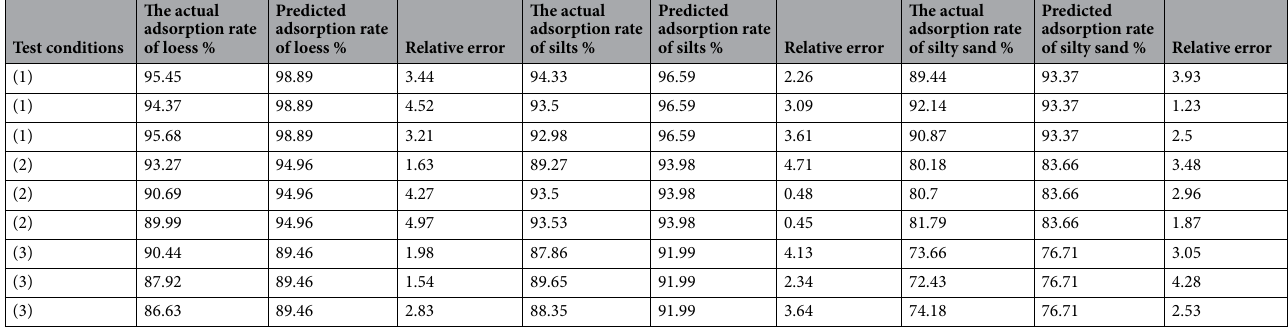
Table 10. Verification results of adsorption rate test.